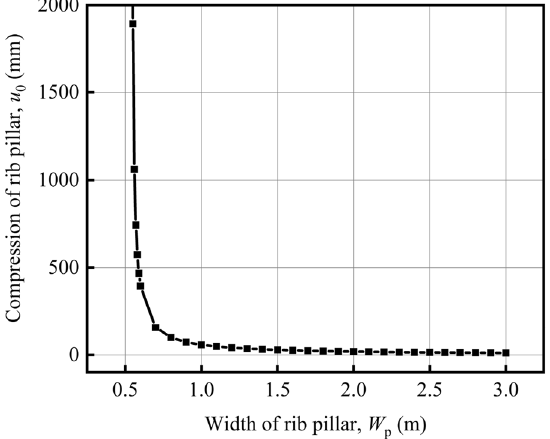
Fig. 14 Compression of the rib pillar under dynamic and static load superposition of the No. 1 haulage